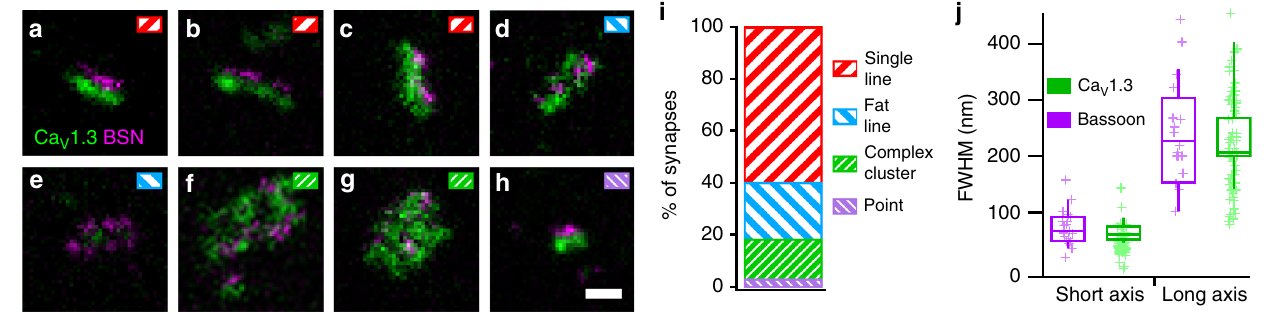
Fig. 1 2D nanoscale anatomy of IHC Ca 2+ -channel clusters. a – h Representative examples of AZs assumed to run roughly perpendicular to the imaging axis at the base of IHCs, with immuno fl uorescence for the Ca V 1.3 Ca 2+ channel (green) and bassoon (magenta), a protein of the presynaptic AZ, imaged with 2D-STED microscopy. Most (~60%) of the clusters seemed to form thin stripes, with Ca V 1.3 and bassoon lying side by side ( a – c ), while some formed somewhat wider stripes, sometimes double stripes (~20%, d , e ). About 15% of the AZs displayed a wider and more complex distribution of Ca V 1.3 and bassoon ( f , g ) and some clusters displayed small punctate staining for both proteins (~5%, h ). Inset markers indicate our subjective classi fi cation of the displayed AZs according to i. Scale bar: 200 nm. i Summary of the distribution of different types of AZs as de fi ned by the apparent shape of the individual AZs ( a – h ) measured with 2D-STED microscopy in our sample of n = 138 AZs from N = 4 mice. j Average dimensions of thin stripe-like clusters of Ca V 1.3 (green) or bassoon (magenta), as presented in a – c , obtained by fi tting a 2D Gaussian function to the image and displayed as full-width at half-maximum (FWHM), from n = 81